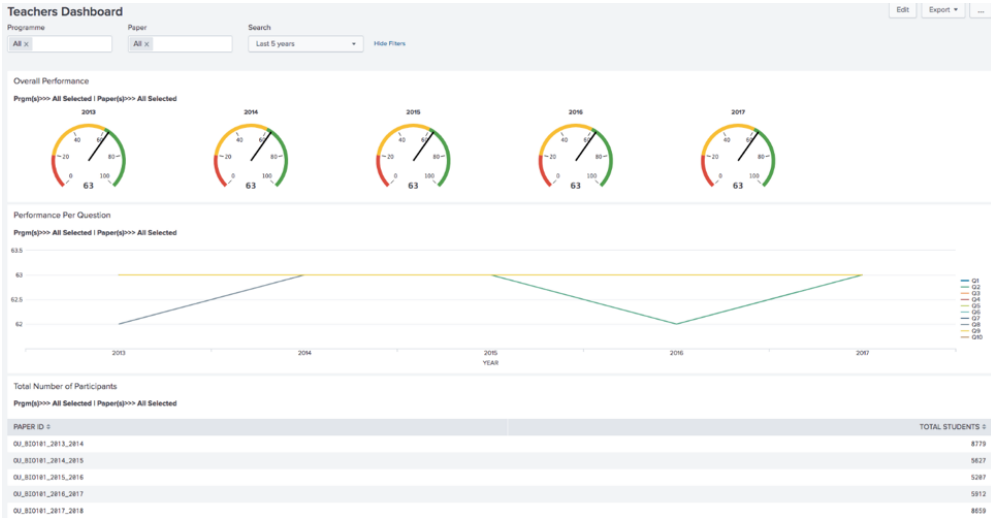
Figure 5. Teachers